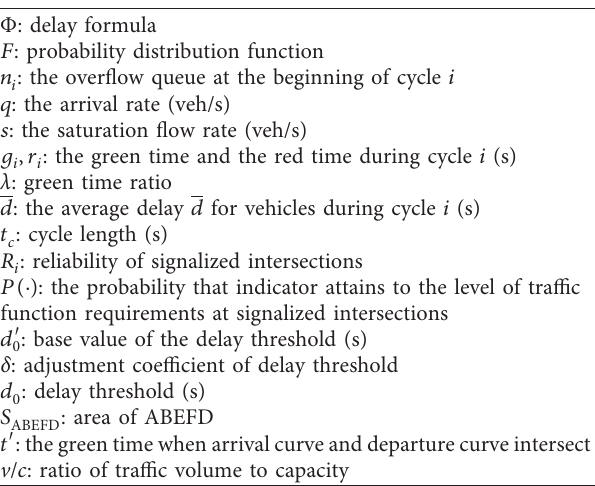
Figure 2: Construction layout for TFR. Table 1: Definition of the